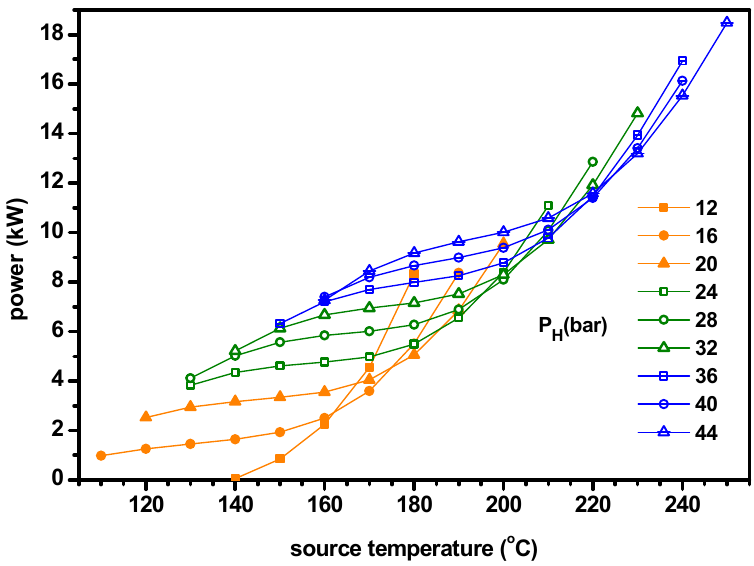
Figure 17. Effect of source temperature on the power. Figure 17. E ff ect of source temperature on the